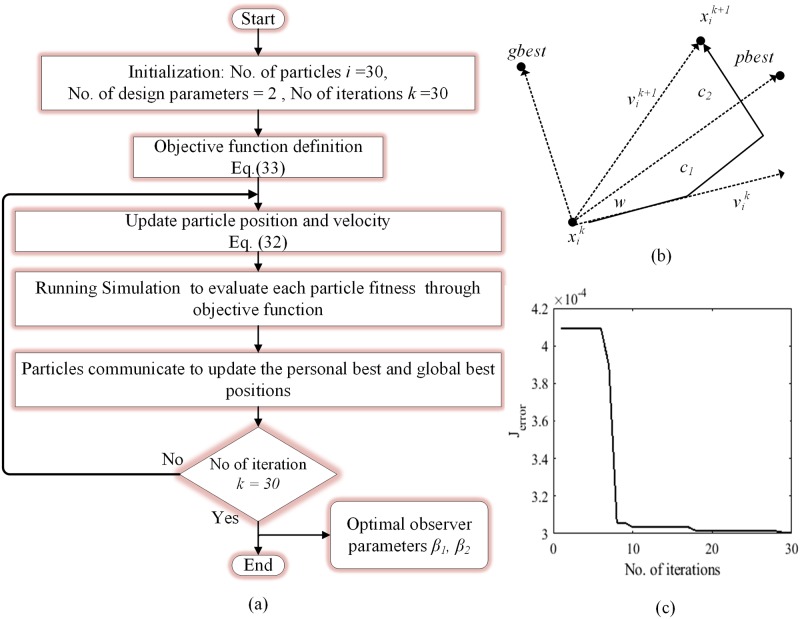
(a) Flow chart for PSO algorithm (b) position and velocity update of particles (c) convergence of PSO.